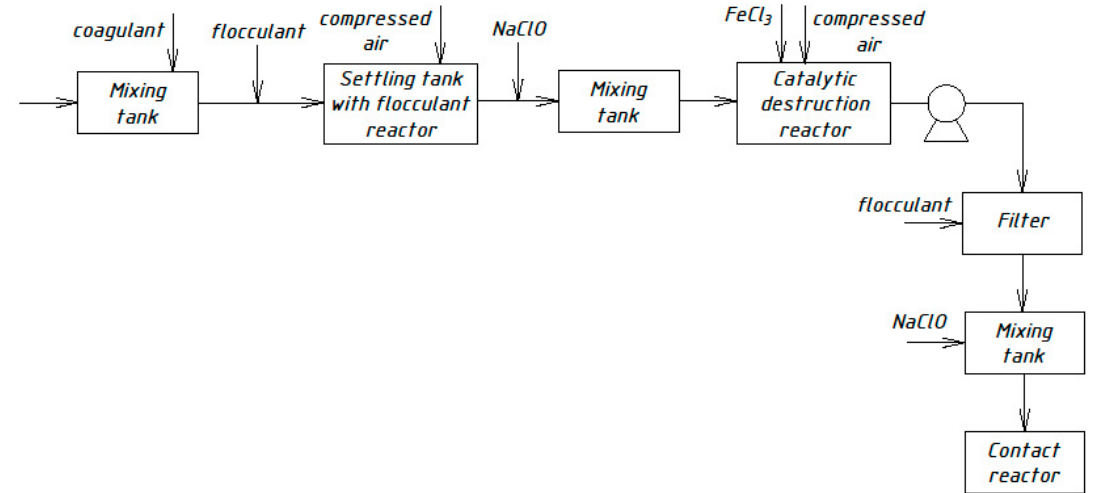
Figure 6. Wastewater treatment scheme with an ozonation unit.